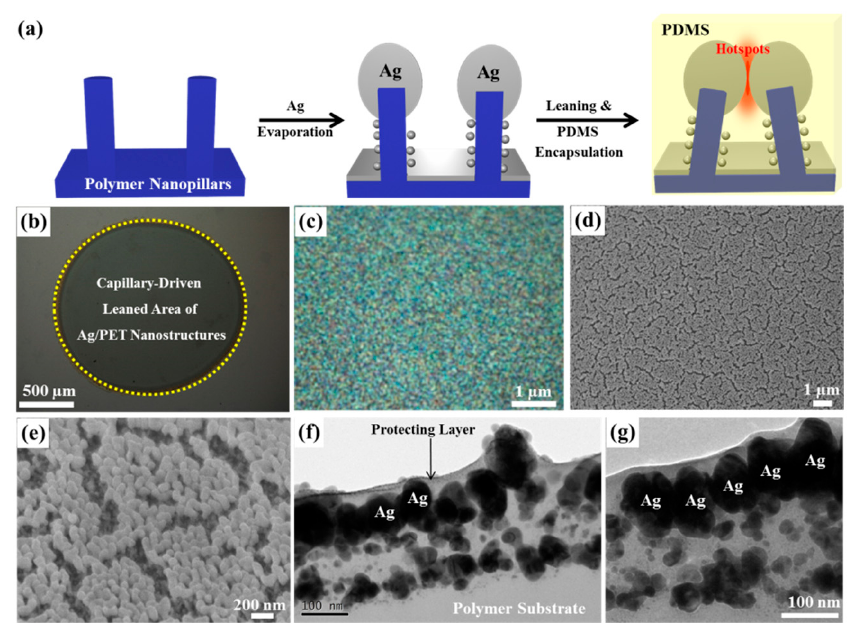
Figure 1. Fabrication of molecule-sensitive and selective nanogap-enhanced surface-enhanced Raman spectroscopy (SERS) sensing platform. ( a ) Schematic illustration of the fabrication process of Ag / PET nanopillars. ( b ) Optical image of the area within which the Ag / PET nanopillars leaned under surface tension (inside the dotted circle), and the as-prepared upright Ag / PET nanostructures (outside the dotted circle). ( c ) Dark field image of the leaning Ag / PET nanopillars, showing strong Rayleigh scattering from the Ag NPs. Scanning electron microscopy (SEM) images of the leaning Ag / PET nanopillars: ( d ) top view, and ( e ) tilted view. ( f , g ) Cross-sectional transmission electron microscopy (TEM) images of the collapsed Ag / PET